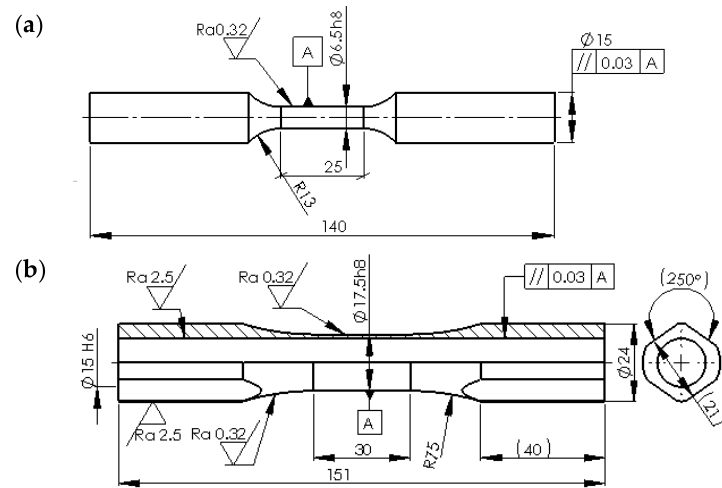
Figure 1. Diagram of test specimens for determination of the fatigue life of the material at elevated temperatures: ( a ) cylindrical specimen used in uniaxial loading tests (unit: mm) and ( b ) tubular specimen used in multiaxial loading tests (unit: mm).